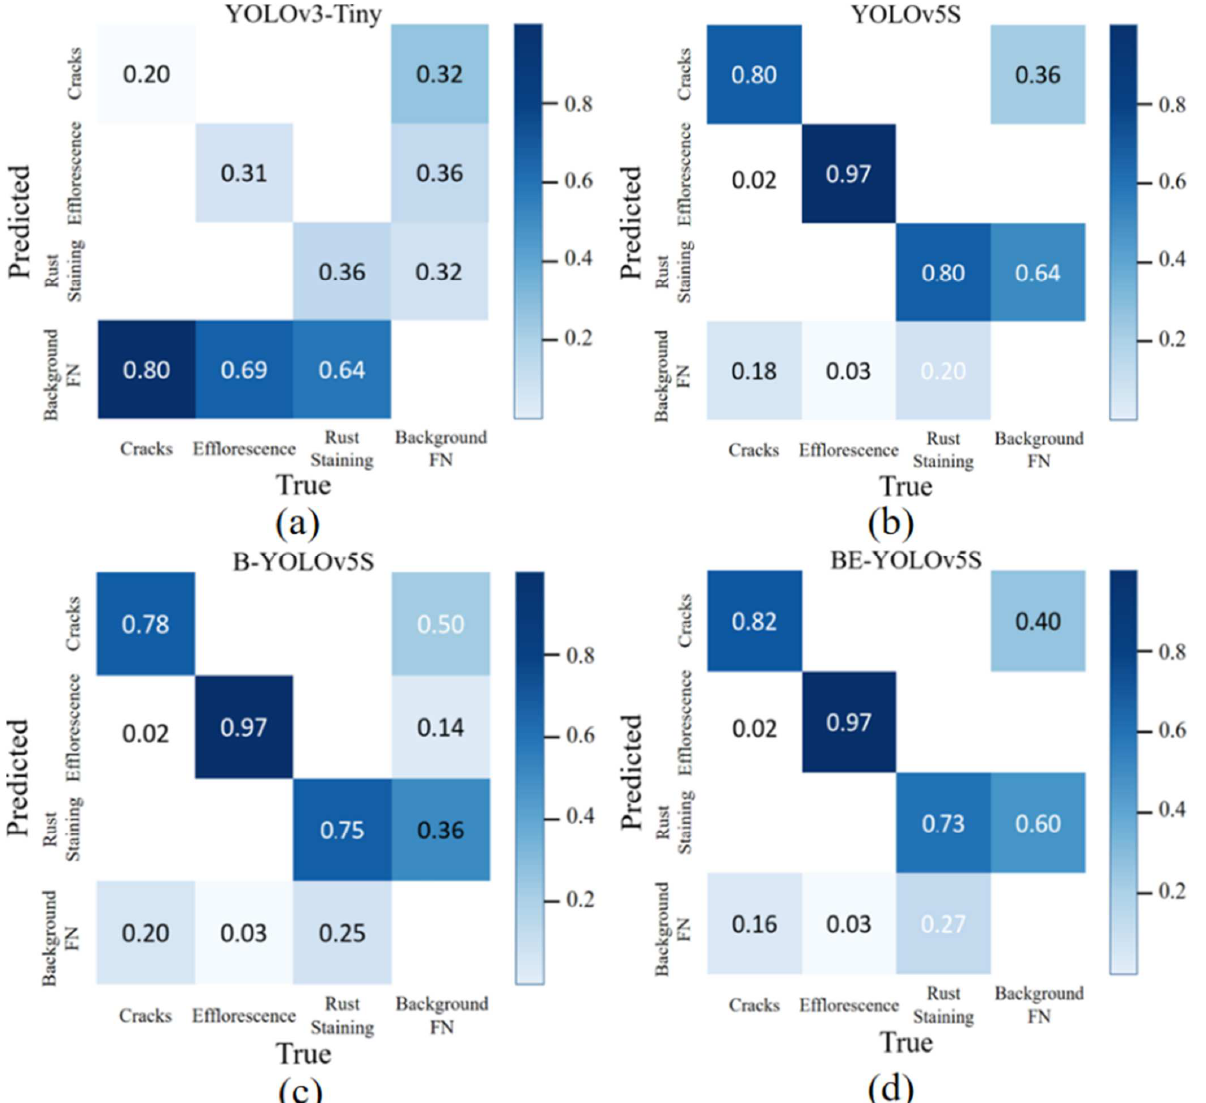
Figure 7. The confusion matrix plot of the relevant experimental models in this paper was tested on the BDD test set. ( a ) YOLOv3-Tiny; ( b ) YOLOv5S; ( c ) B-YOLOv5S; ( d ) BE-YOLOv5S.